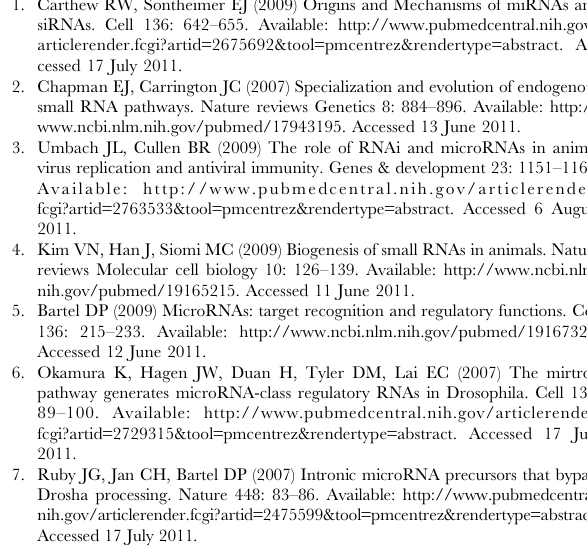
Table S1 Reads mapped to the known miRNAs (miR- base version17). Table S2 Abundance of MHV68 miRNA, miRNA* and their isoforms. The sequences underlined indicate the most abundant read. The annotated miRNA sequences (miRbase version 17) were indicated in column miRbase. Five miRNAs showing 5 9 isoforms are marked in yellow. Table S3 Twenty-eight novel miRNAs in the mouse genome represented by normalized reads from wide- type (wt), Dicer- (dicer) and Dgcr8-knockout (dgcr8) mice [ 12 ] . Table S4 Newly annotated and previously described noncanonical miRNAs. The column of # Reads represents the number of reads in the current sequencing data for each mature miRNA sequence. Normalized reads from wide-type (wt), Dicer- (dicer) and Dgcr8-knockout (dgcr8) mice [12] were included. (XLSX)